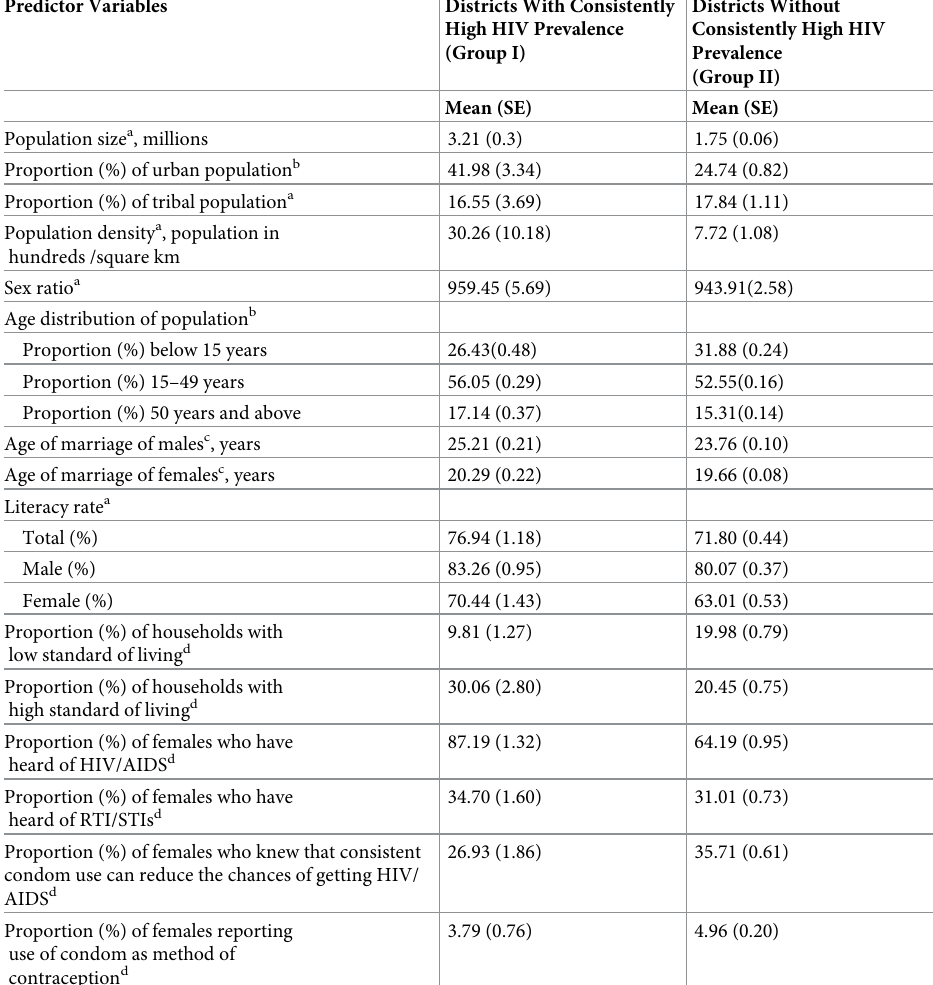
Table 1. Comparison of Population Profile (A), Socio-Economic Factors (B), Awareness about HIV/STIs and Condom Use (C) in the Districts with and without Consistently High HIV Prevalence in India: 2007–12. Predictor